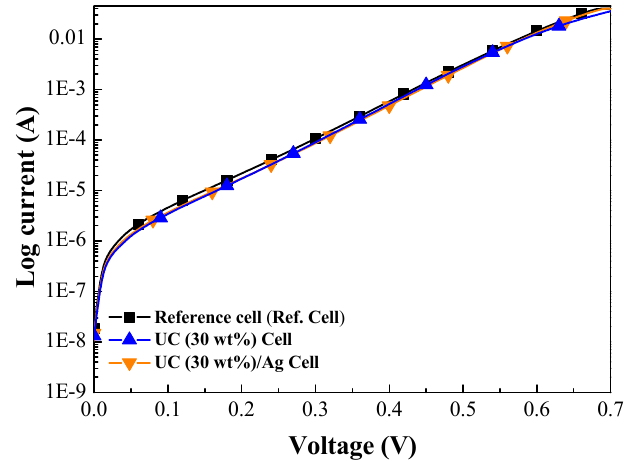
Figure 8. Dark I-V curves of the reference cell, UC cell, and UC / Ag cell.